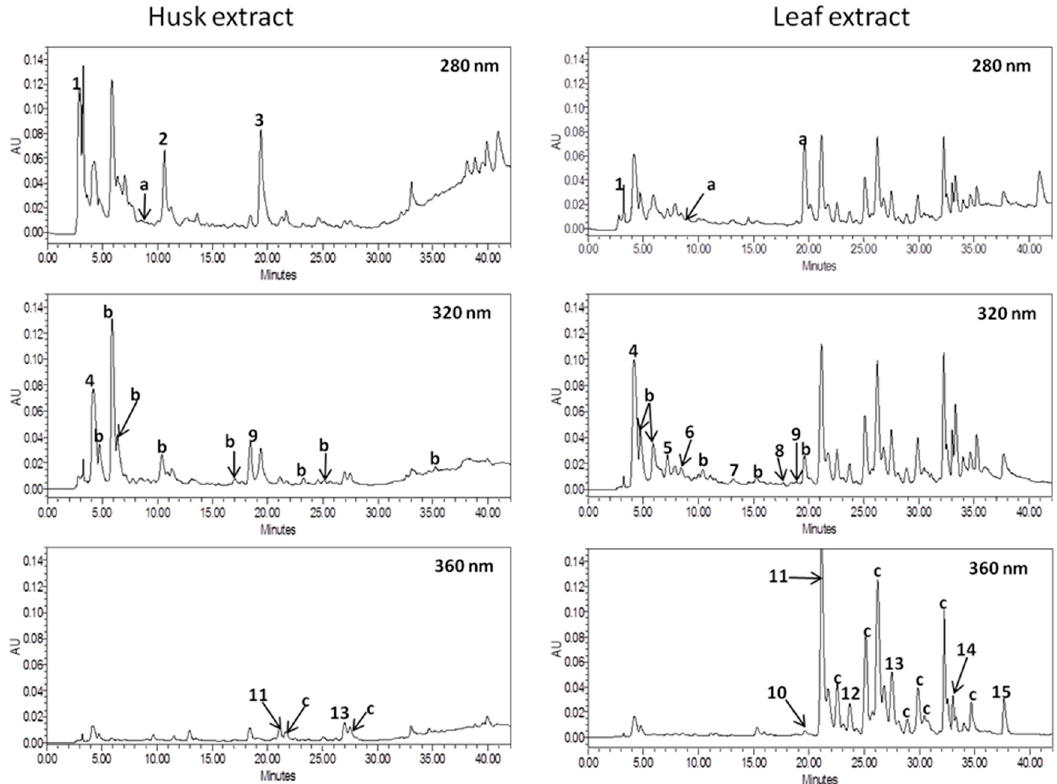
Figure 3. Chromatograms of walnut leaf and husk extracts at λ = 280 nm, 320 nm, and 360 nm. Peaks: 1, gallic acid; 2, syringic acid; 3, ellagic acid; 4, neochlorogenic acid; 5, chlorogenic acid; 6, caffeic acid; 7, p -coumaric acid; 8, ferulic acid; 9, sinapic acid; 10, rutin; 11, Quercetin 3-galactoside; 12, myricetin; 13, quercetin 3-rhamnoside; 14, quercetin; 15, kaempferol; a, unidentified hydroxybenzoic acids; b, unidentified hydroxycynnamic acids; c, unidentified flavonols.